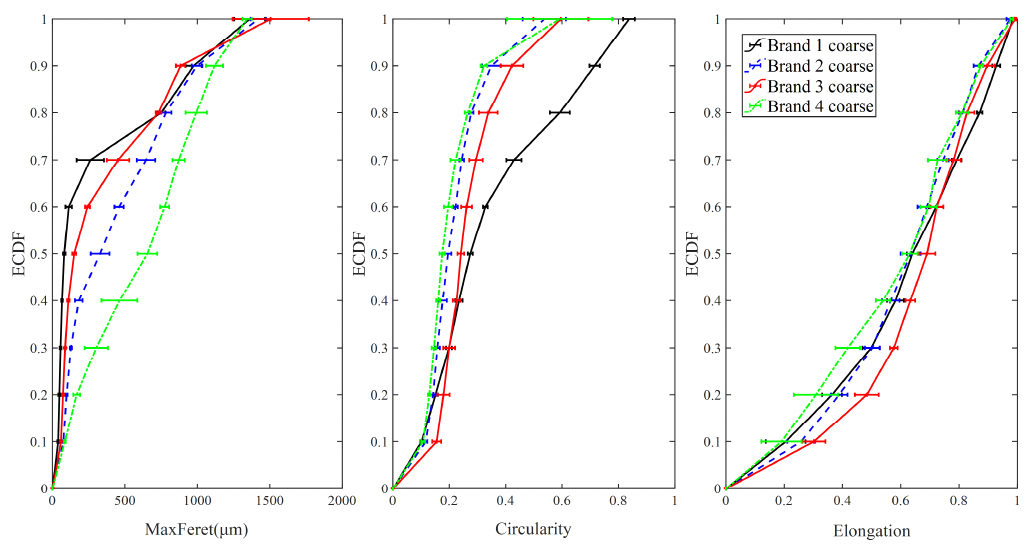
Figure 8. The empirical cumulative distribution function of shape factors for coarse particles.